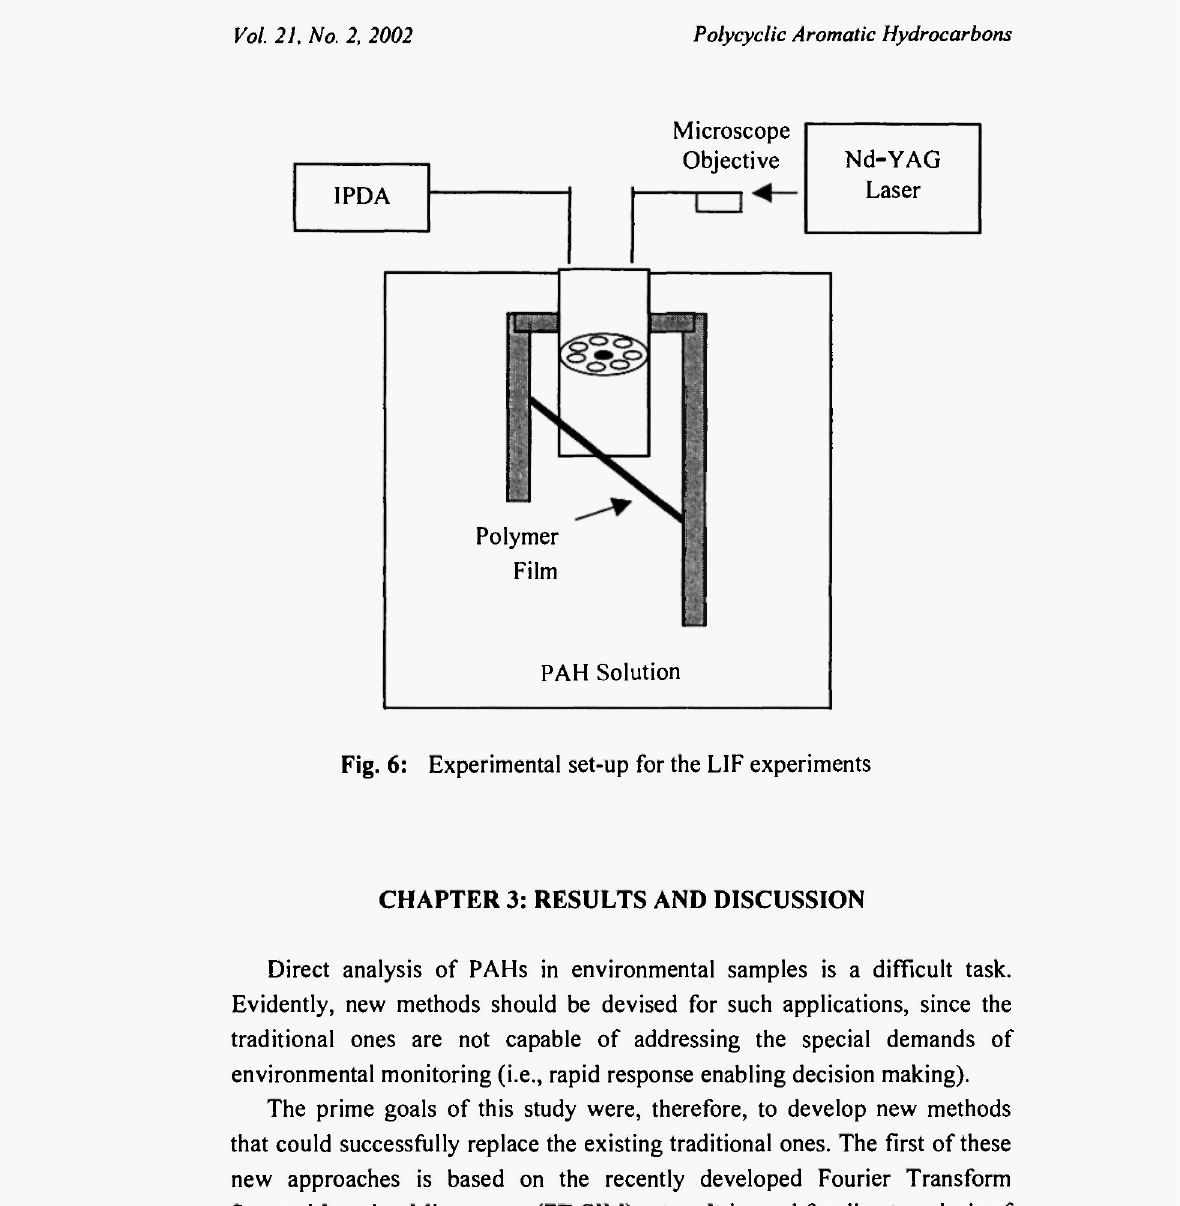
CHAPTER 3: RESULTS AND